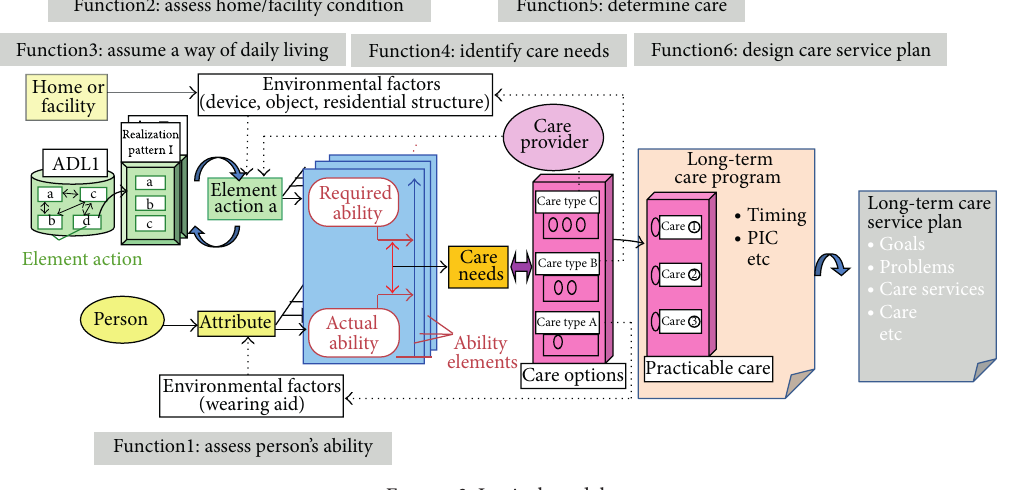
Figure 3: Logical